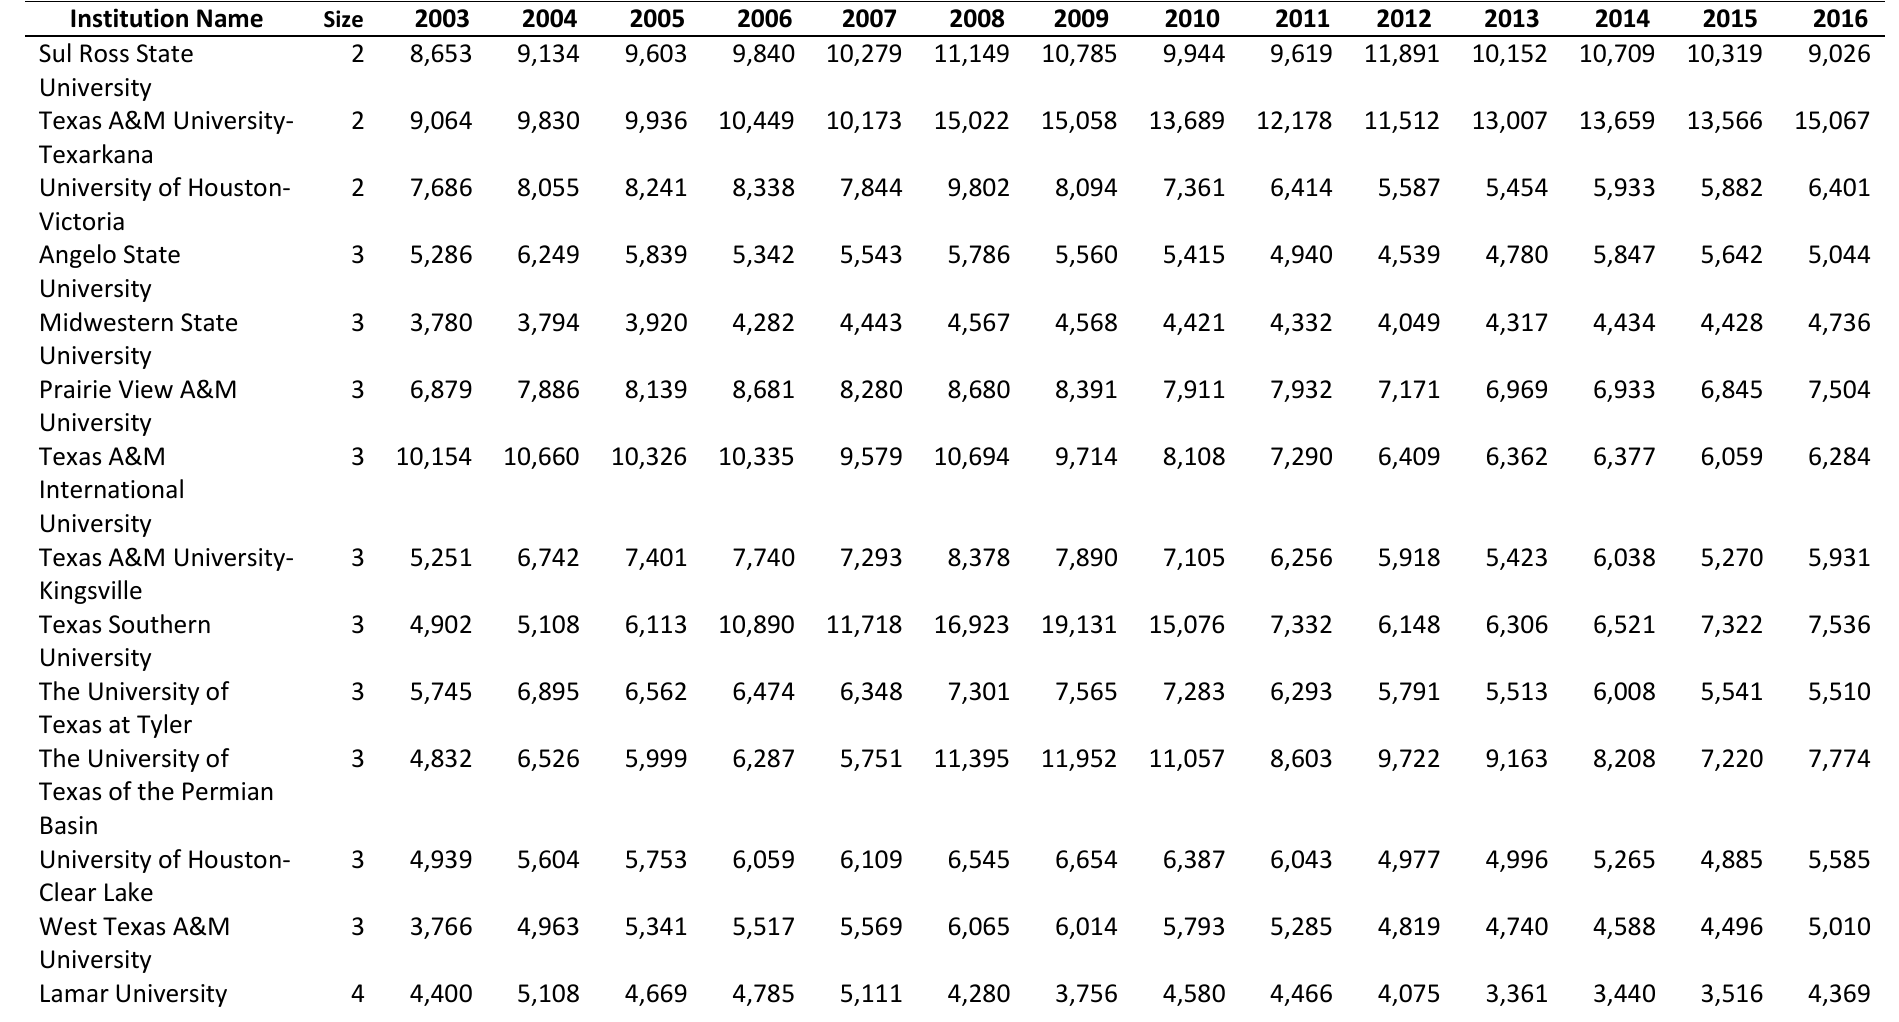
Table 4: State Appropriations per FTE Student for FY 2003 to FY 2016 by Institutional